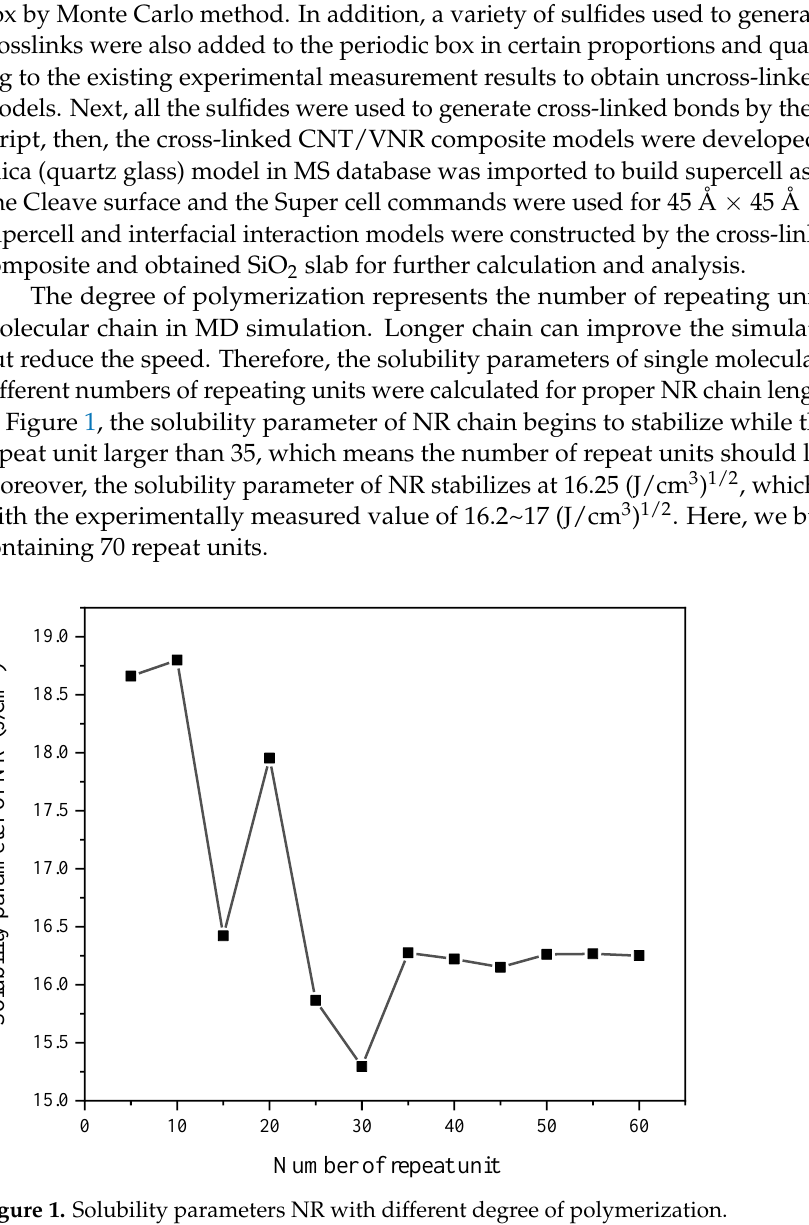
where v is the number of crosslinked repeat units and N 0 is the total number of repeat